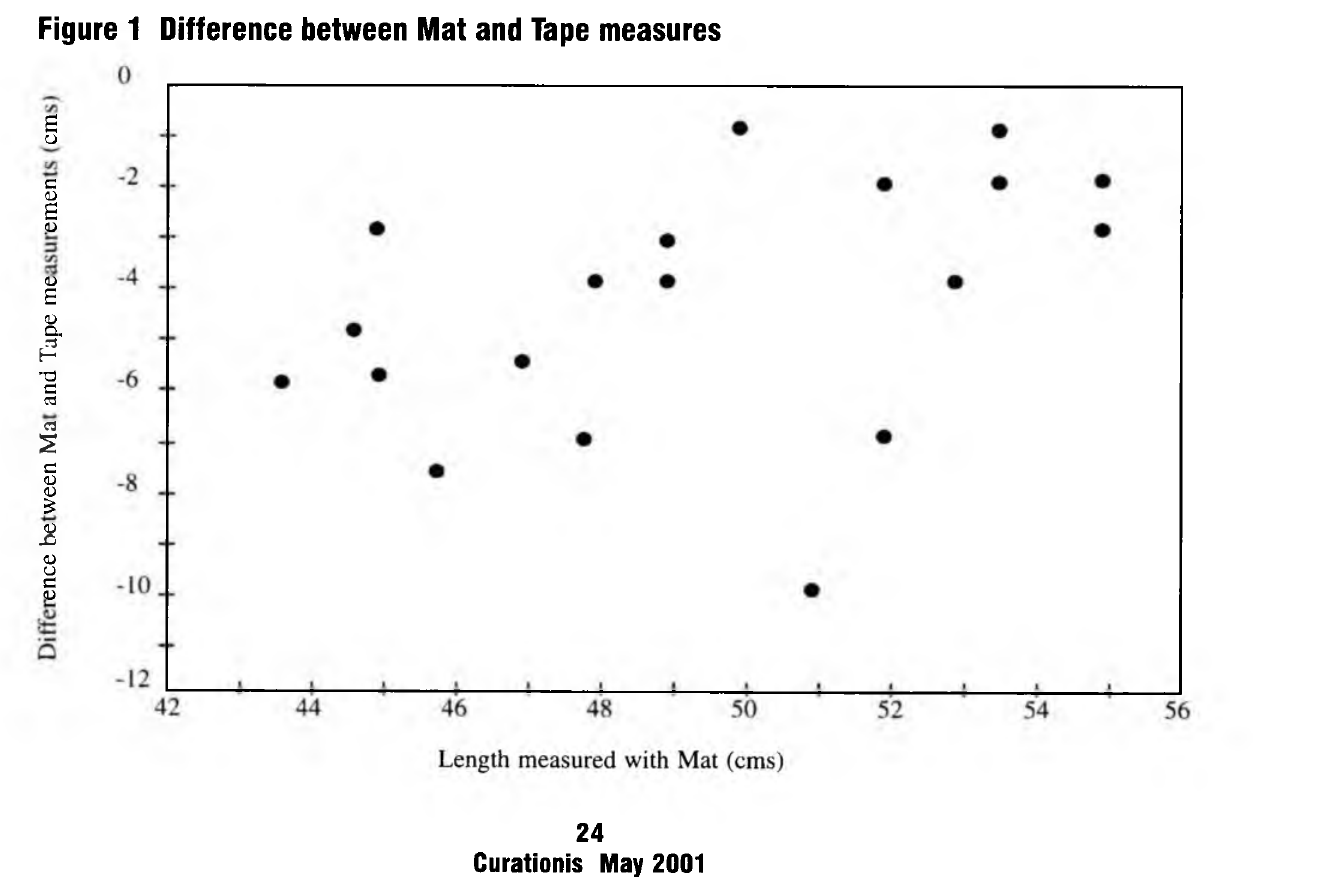
Figure 1 Difference between M at and Tape